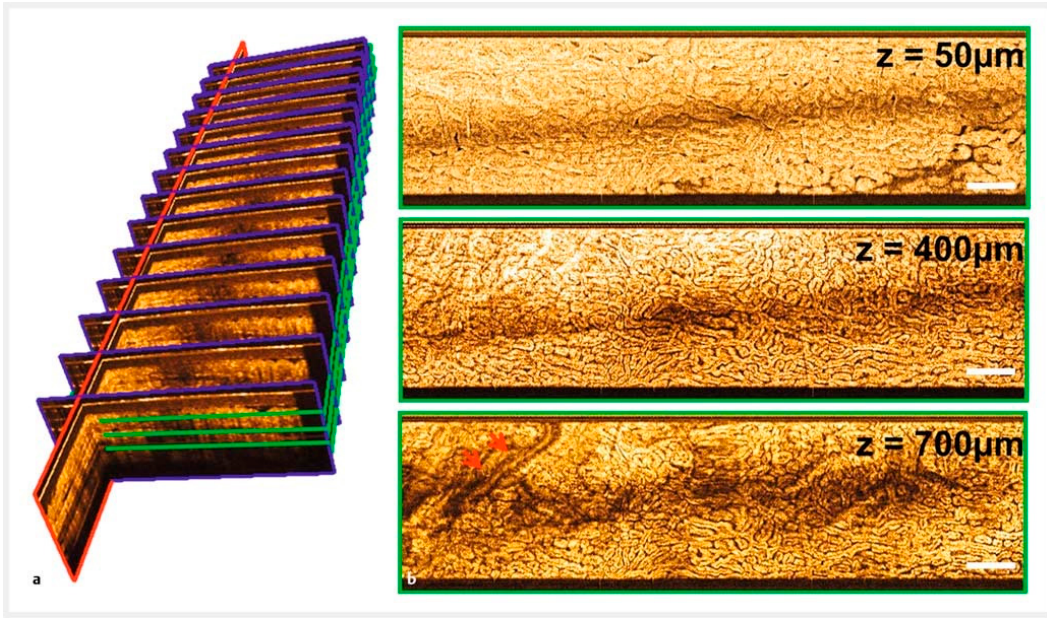
Figure 2. Combined en face and volumetric OCT dataset visualization. ( A ) Volumetric OCT dataset with cross-sections (blue), longitudinal (red) and en face (green) views. ( B ) Intrinsic co-registration leads to depth-resolved en face OCT images at various depths, revealing superficial mucosal architecture near the surface and mucosal patterns in greater detail and contrast, as well as microvasculature, in deeper images. Scale bars 1 mm. Figure and caption adapted from Ahsen et al. 2019.